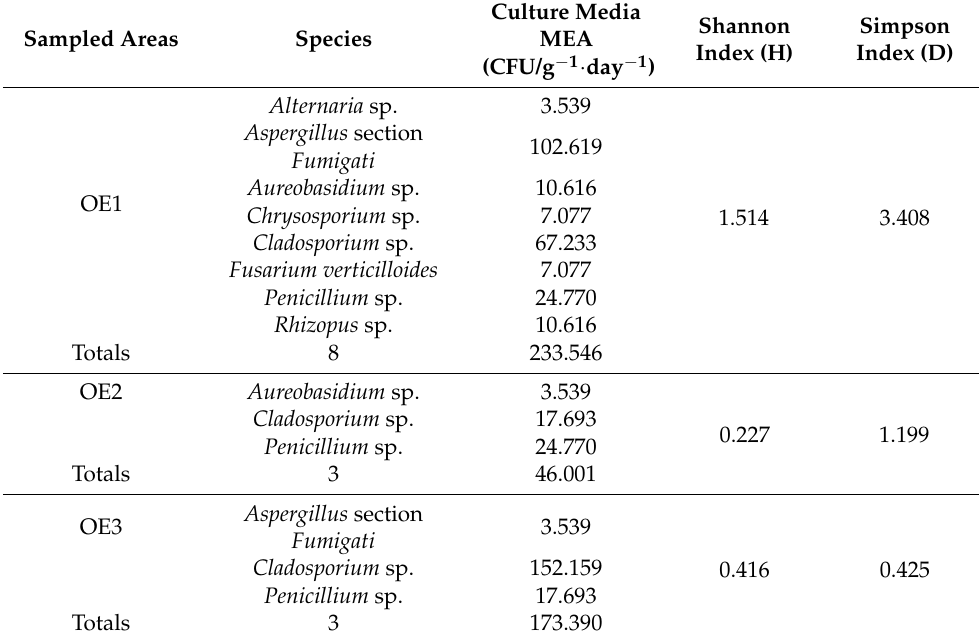
Figure 5. Fungal qualitative distribution in both MEA (dotted circles) and DG18 (full circles). As- signed to each circle is the percentage each genus occupies within the total results. Table 2. Shannon and Simpson indexes to assess species diversity.